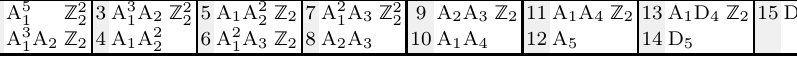
Table 8 . Algebras of maximal rank for the heterotic Z 5 and Z 6